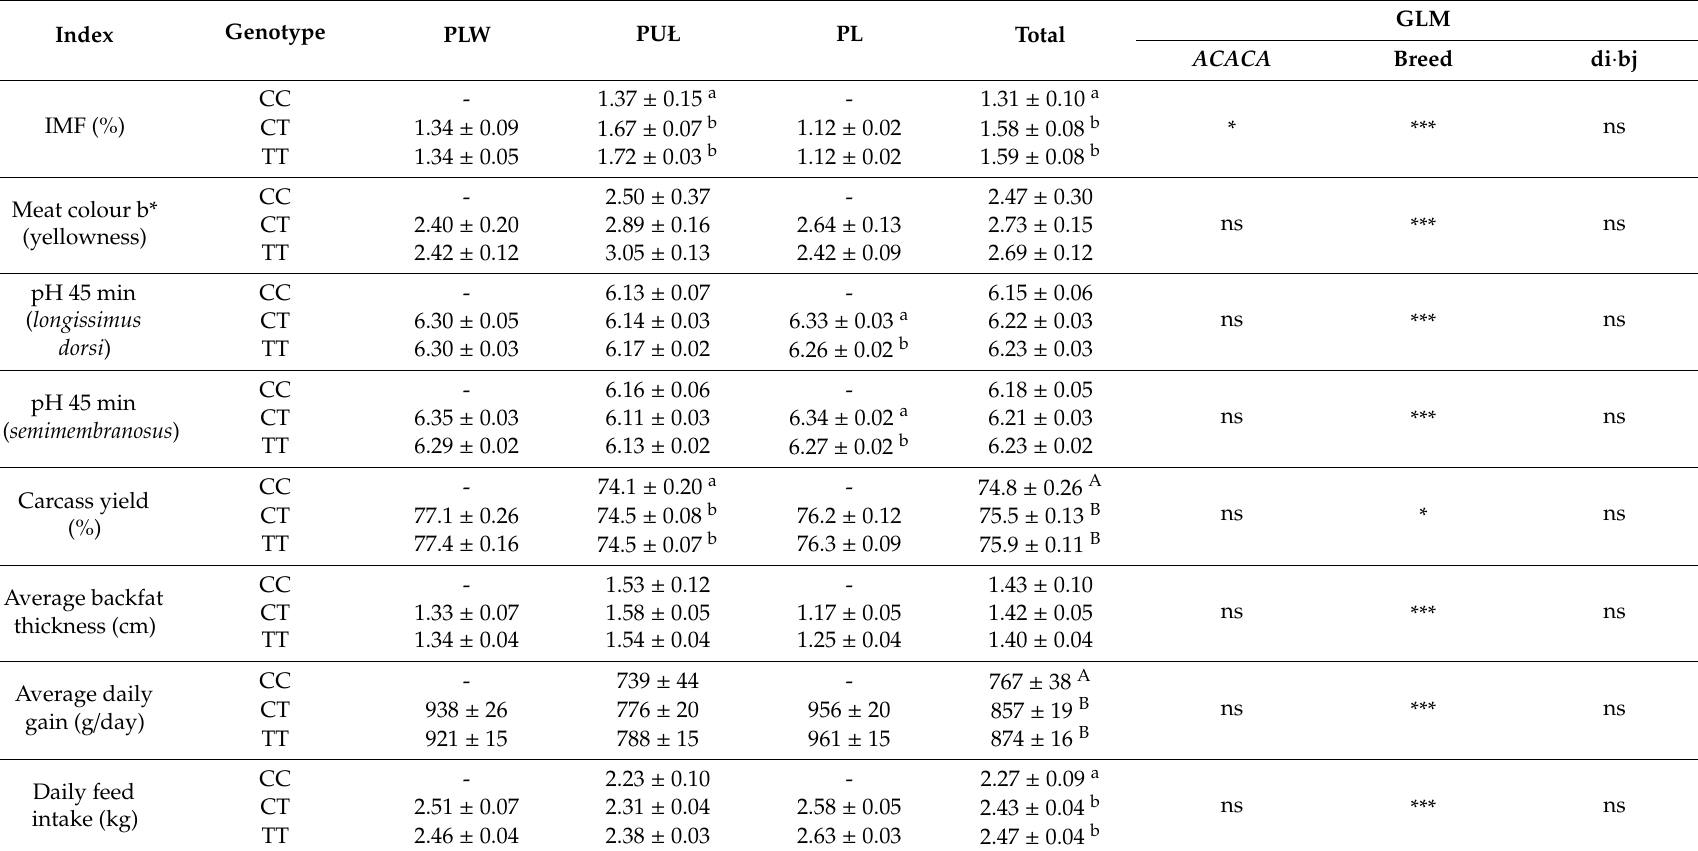
Table 3. Association of the ACACA mutation and analysed traits (LSM ±